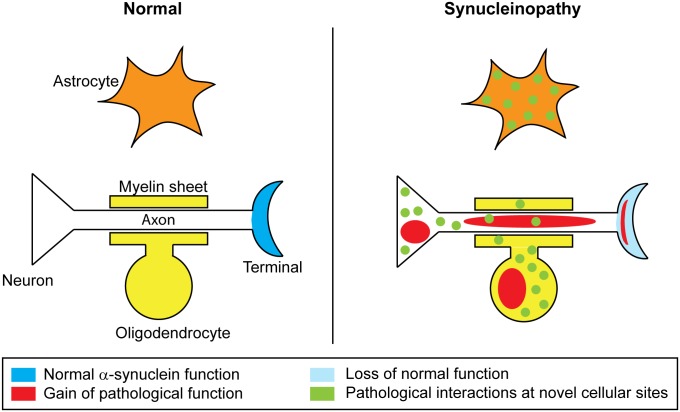
Possible molecular pathways initiated by αSN in disease.Under normal conditions αSN is predominantly located in nerve terminals (blue). During disease αSN undergo aggregation and this lead to novel conformation-dependent interactions (red), which represents a gain of function. In addition, αSN species (monomeric and oligomeric) are concentrated at abnormal sites, like axons and the cell body, or in astrocytes and oligodendrocytes, which give rise to novel interactions because new partners are introduced (green). Finally, an abnormal sorting and aggregation leads to a loss of, or reduced normal αSN concentration in nerve terminals where critical monomer specific interactions will be compromised thus representing a loss of function.